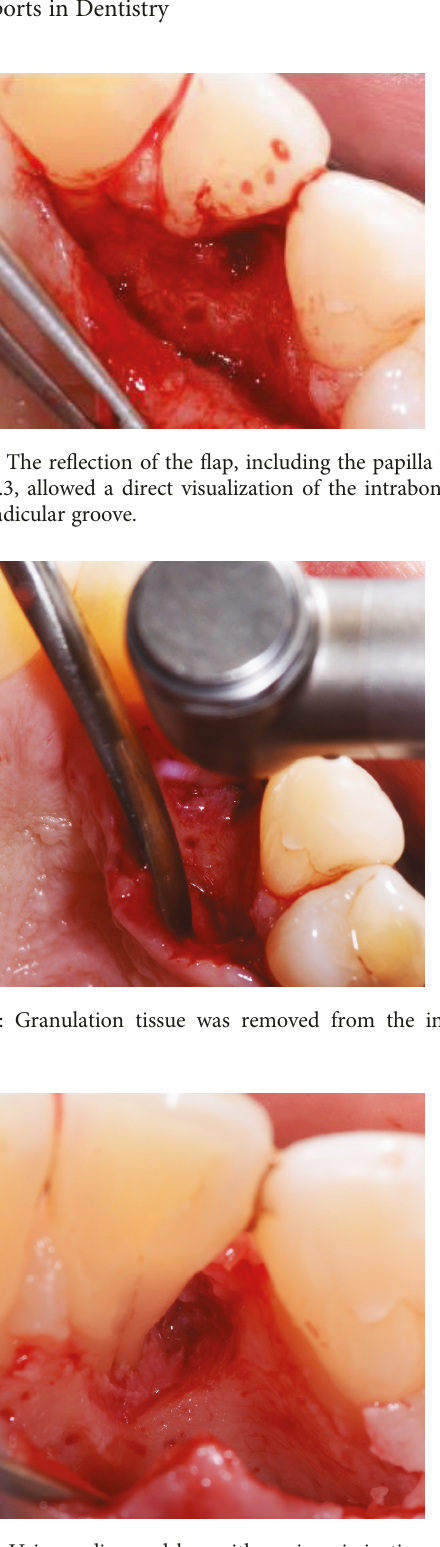
Figure 6: Using a diamond bur with copious irrigation of sterile saline solution, the enamel alteration was removed.